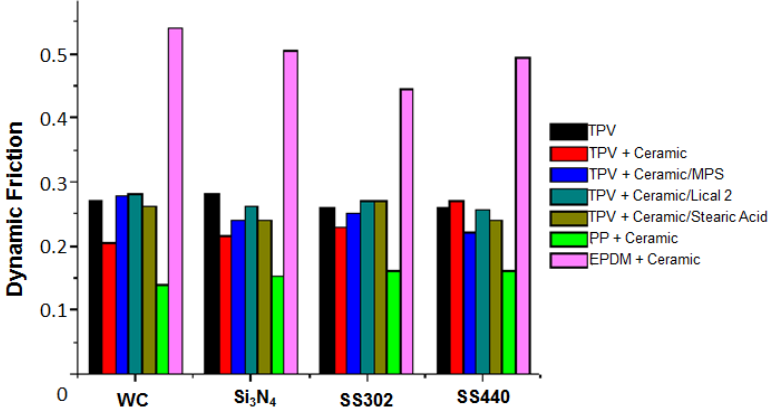
Figure 7. Friction values for thermoplastic vulcanizate, its constituents and composites. Reprinted from [24] with permission. Copyright Society of Chemical Industry, 2012.